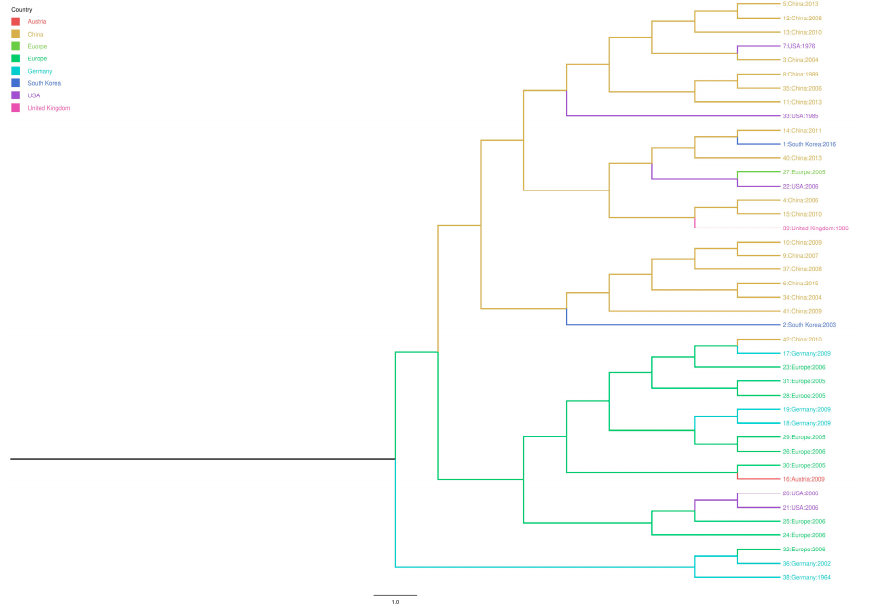
Figure 2. Bayesian time-scaled phylogeny of porcine parvovirus (PPV) ( NS1 , VP1 , and VP2 genes) with inferred geographical location states. The branches of the maximum clade credibility tree were colored according to the most probable location state of their descendent nodes. The color codes are defined in the insert legend. Viruses 2017 , 9 , 196